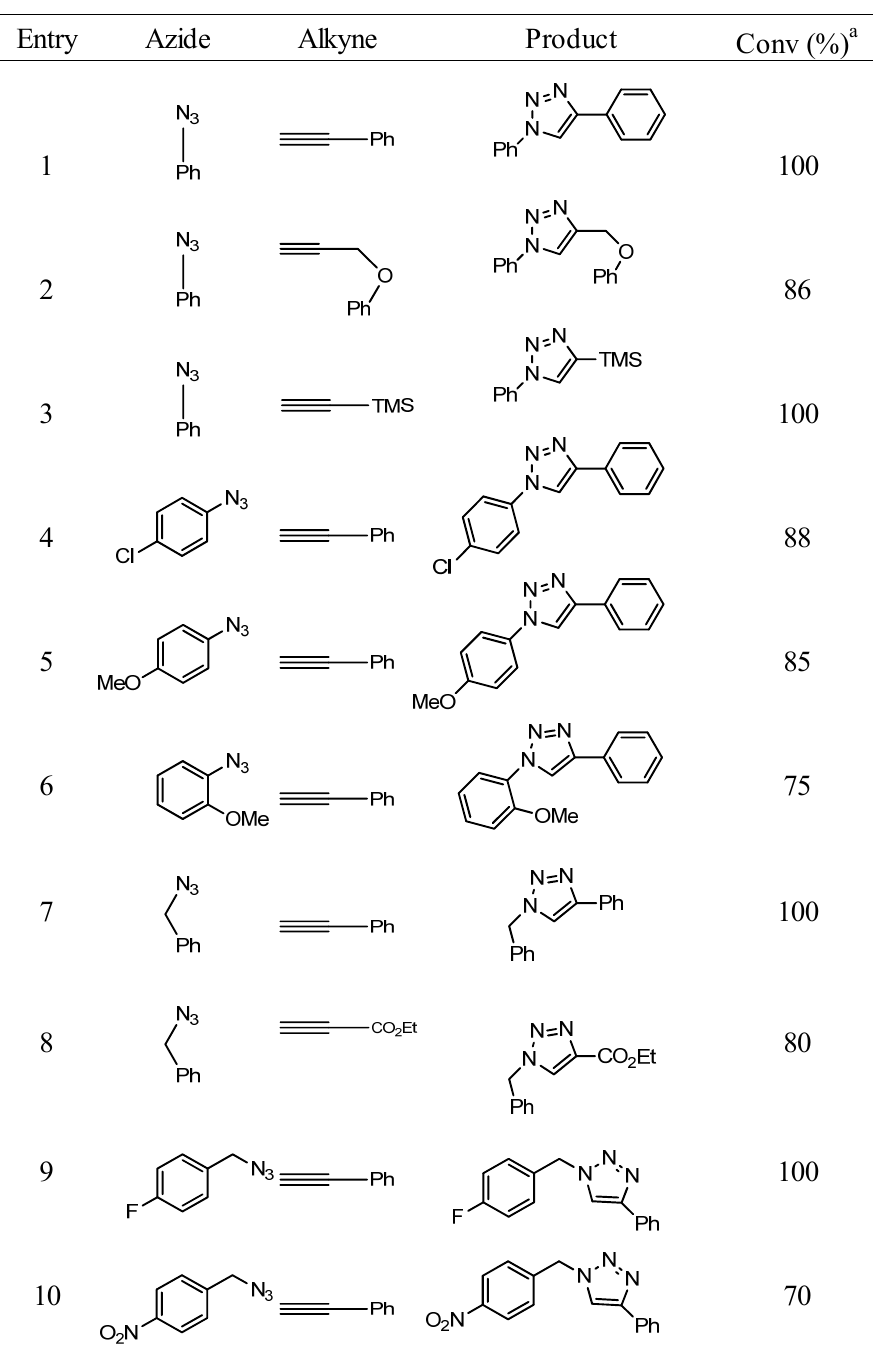
Table 4. Results for solvent-free microwave promoted [3+2] cycloaddition of various azides with terminal alkynes in the presence of